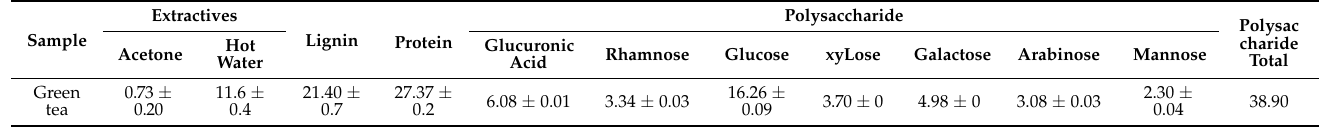
Table 2. Chemical composition of green tea waste biomass (%).